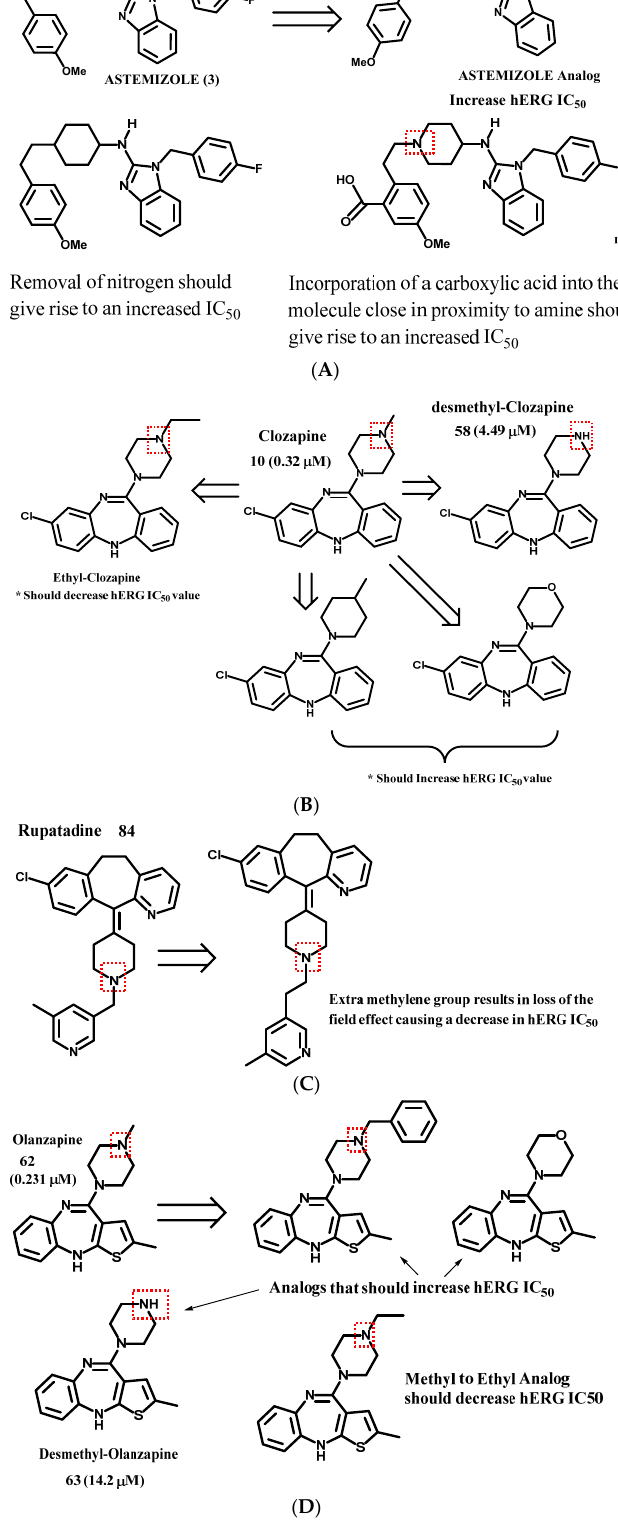
Figure 4. Examples of hERG interaction trend predictions, ( A ) Astemizole template. Removal of the -CH2- should give rise to a molecule whose protonated nitrogen undergoes a ‘field effect’ and thus should give rise to a molecule that has a higher hERG IC 50 . ( B ) Clozapine template. ( C ) Rupatadine template. ( D ) Olanzapine template.